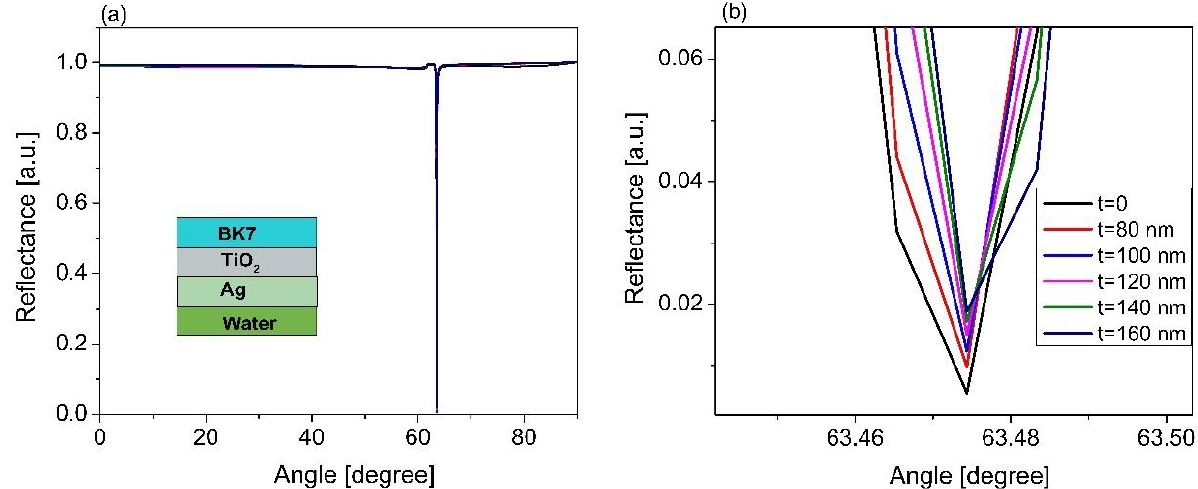
Figure 4. ( a ) Simulated results of TiO 2 thickness changed from 80 nm to 160 nm based on the sensor structure of the BK7/TiO 2 /Ag/sensing medium; ( b ) magnified view of ( a ). Table 3. Estimation of the sensitivity and detection accuracy of the BK7/TiO 2 /Ag-based sensor. TiO 2 80